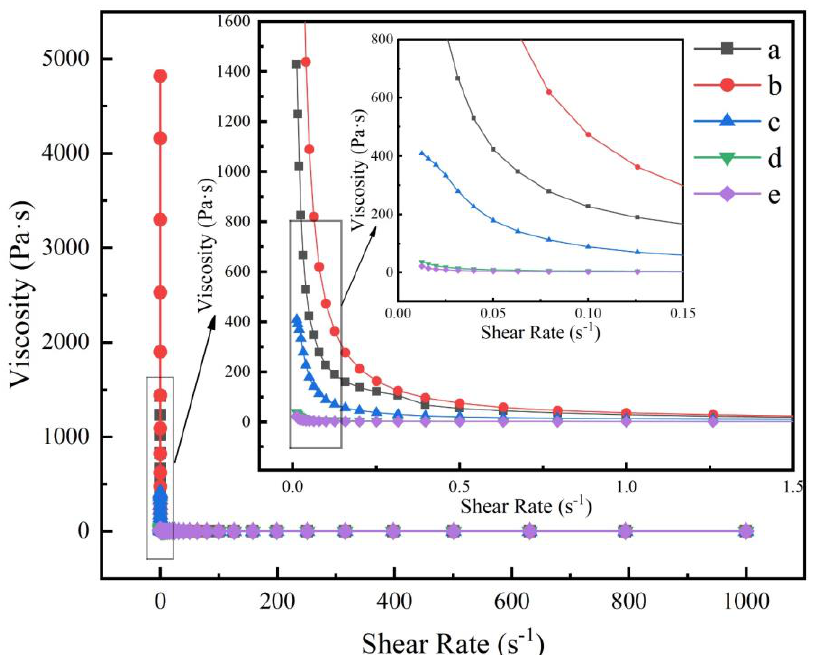
Figure 6. Viscosity−shear rate curves for cement−water slurries added with different amounts of STPP: (a) without STPP, (b) with 0.05% STPP, (c) with 0.1% STPP, (d) with 0.2% STPP, and (e) with 0.4% STPP.